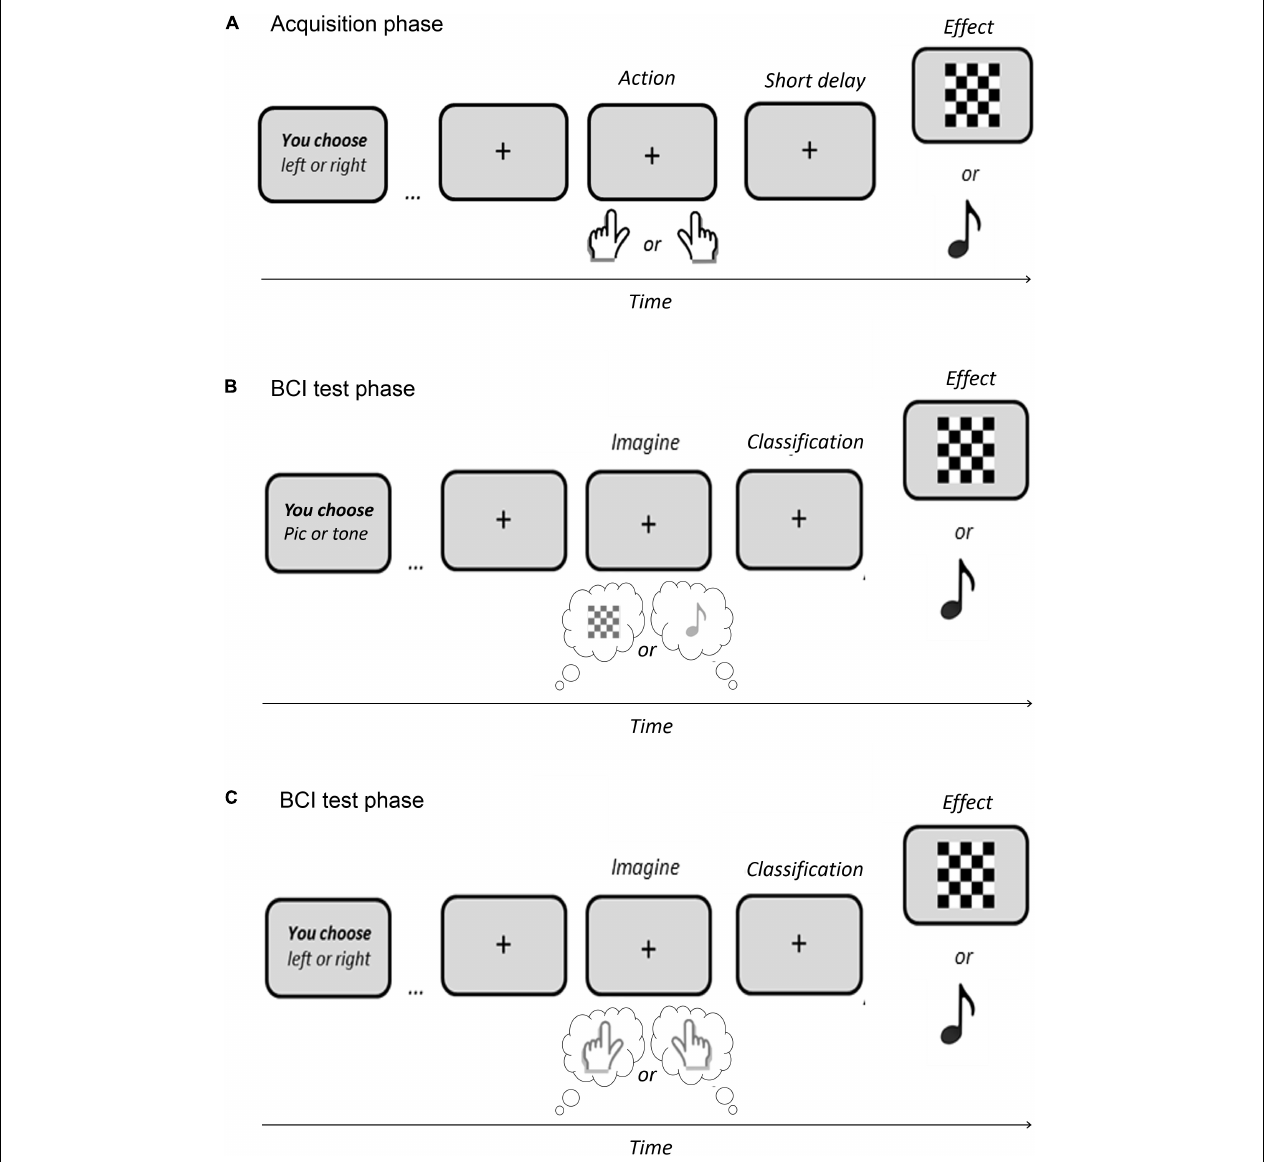
FIGURE 2 | Example of an Ideomotor BCI paradigm. (A) Acquisition phase aiming to link simple actions with specific effects (e.g., right key press → visual effect vs. left key press → auditory tone). (B) Test phase of a BCI based on the user’s active representation of the effect. (C) Test phase of a BCI based on the user’s active representation of the